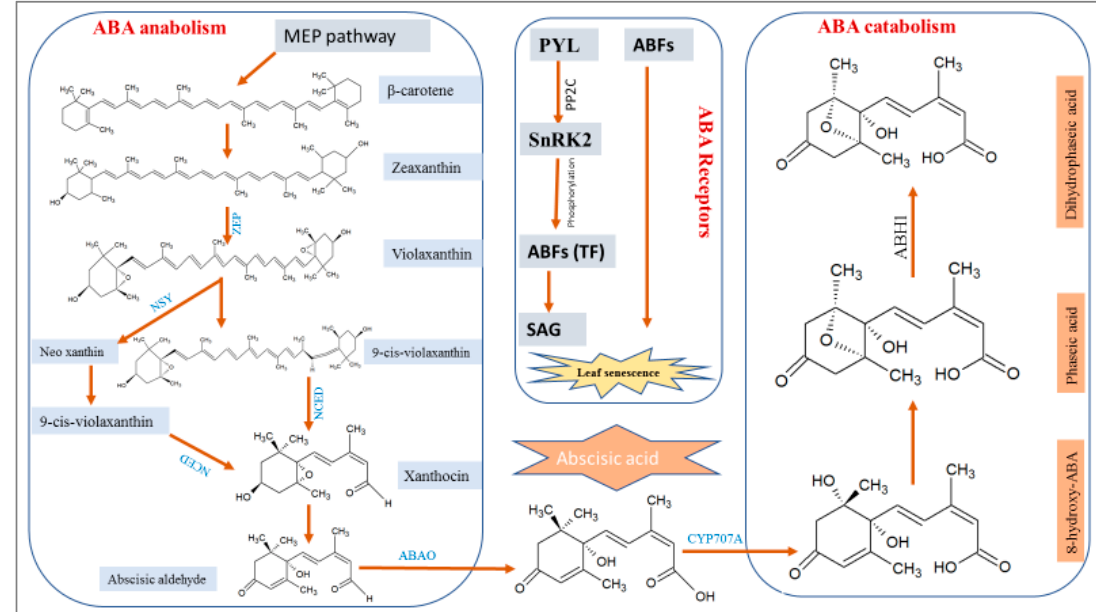
Figure 1. Abscisic acid (ABA) biosynthesis, ABA catabolism, and ABA signaling sensors (receptors) pathways. SAG: senescence-associated gene, In MEP (Methyl Erythritol Phosphate), β -carotene is